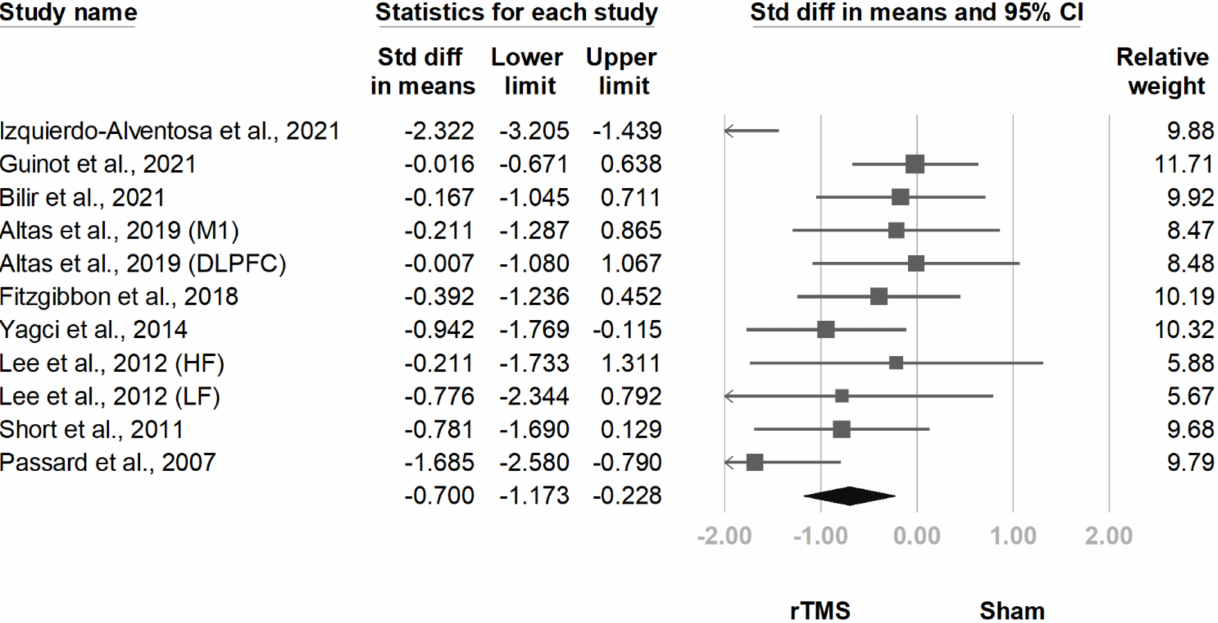
Figure 3. Forest plot of standardized mean differences in Fibromyalgia Impact Questionnaire after treatment. Squares indicate effect sizes of individual studies, lines indicate 95% CI, and diamond indicates the summarized effect size.